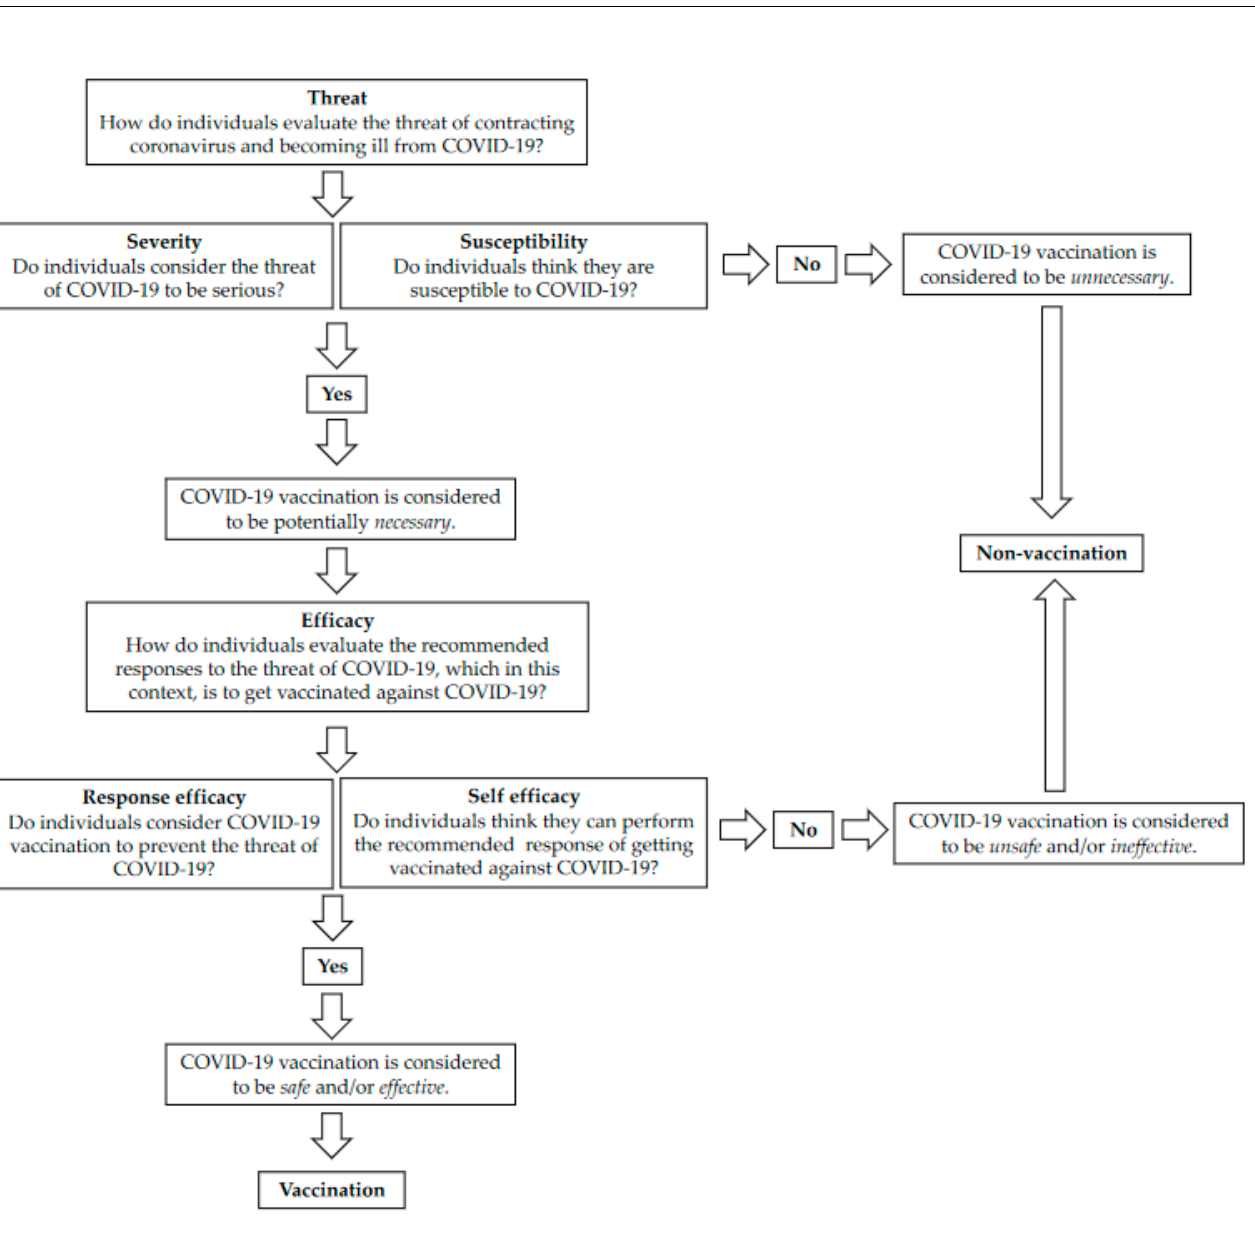
Figure 2. Vaccination journey in an abstract sense.